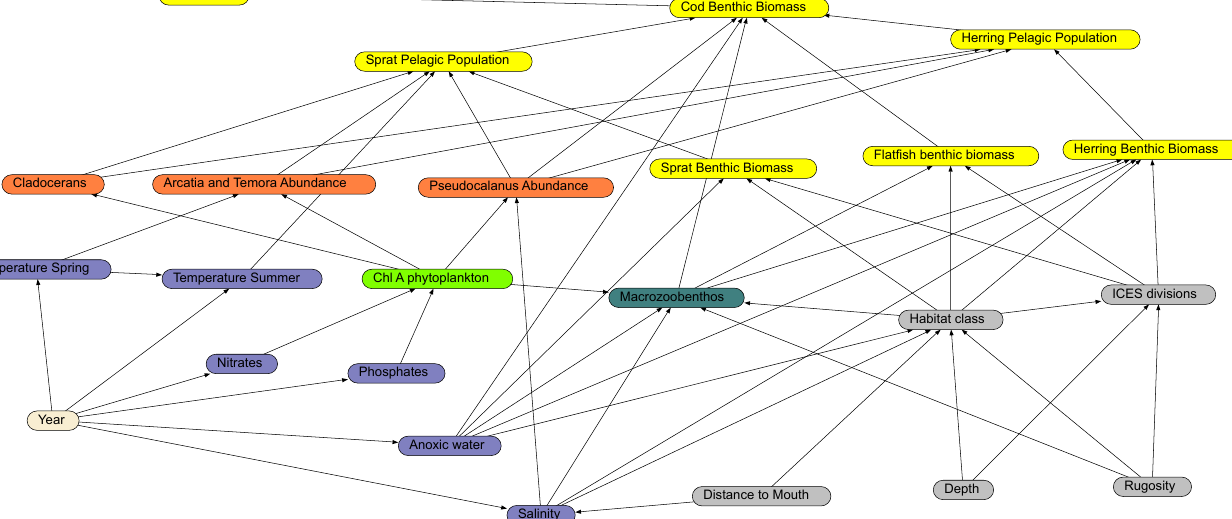
Figure 3. The completed BN with boxes and arrows showing the parameters and dependencies included. The box colors highlight the structural (grey), environmental (purple), phytoplankton (light green), zooplankton (orange), macrozoobenthos (brown), fish (yellow), and time (beige) components. Each arrow represents a modelled conditional probability element. The data that underpin each node in the BN are described